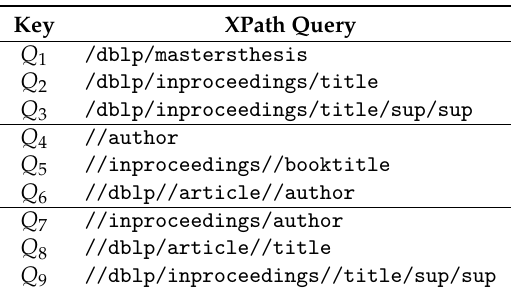
Table 3. Set of queries for DBLP dataset.